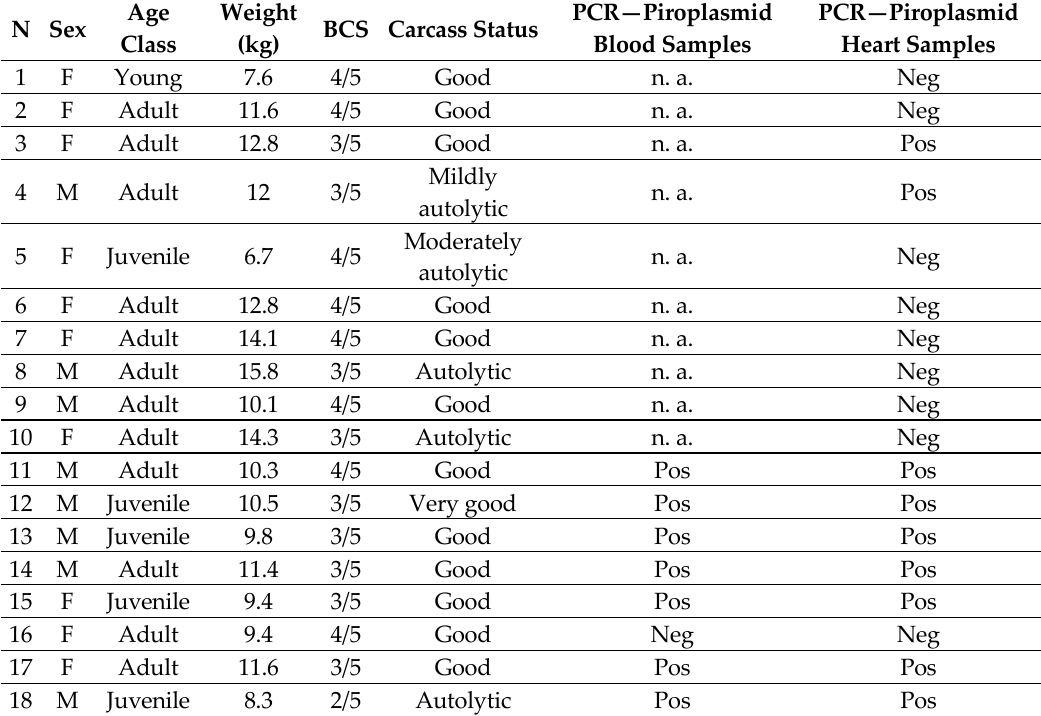
Table 1. Details of the sampled Eurasian badgers: sex, age class, weight, body condition score (BCS), status of the carcass at the time of sampling, availability of different tissues and results of the PCR for amplification of piroplasmid DNA. n.a.: not